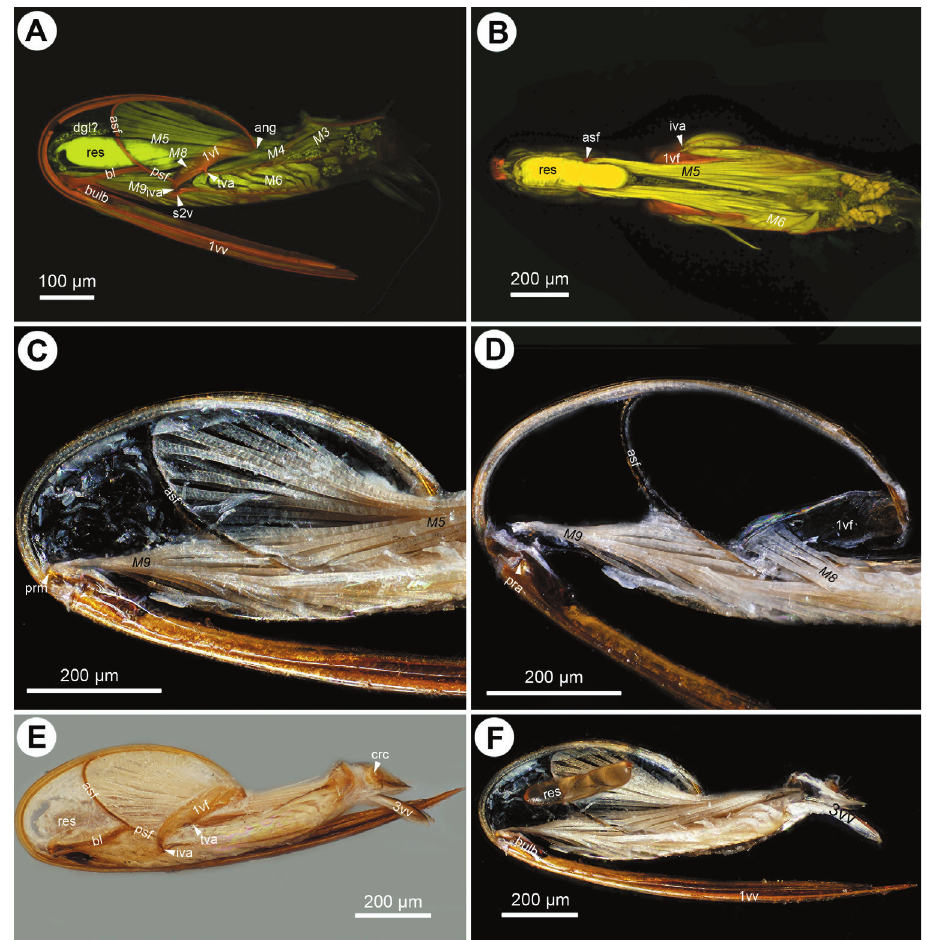
Figure 5. CLSM micrographs and bright field image showing the female terminalia of Ceraphron sp. A CLSM, lateral view (doi: 10.6084/m9.figshare.156445) B CLSM, frontal section, dorsal view (doi: 10.6084/m9.figshare.156447) C bright field, lateral view D bright field, medial view, dorsal T9-second valvifer muscle removed e bright field, medial view, dorsal T9-second valvifer muscle intact; F, bright field, medial view, venom gland reservoir intact. All anterior to